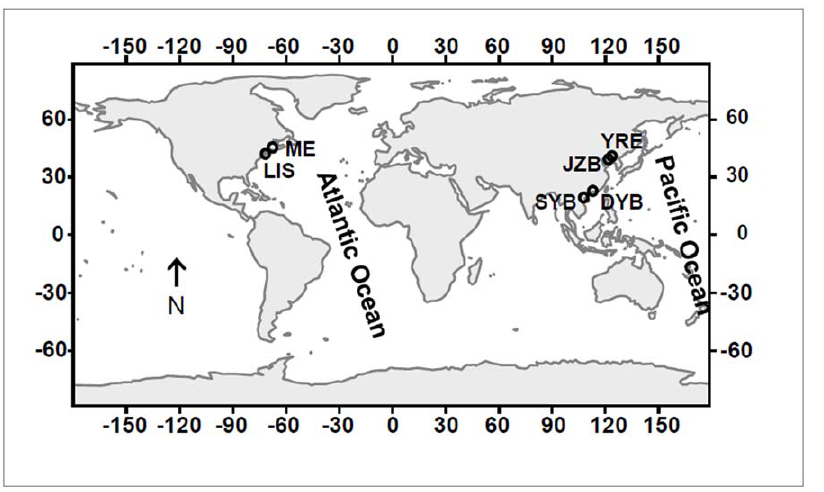
Figure 1. Sampling locations. LIS, Long Island Sound, Connecticut, USA; ME, Penobscot Bay, Maine, USA; SYB, Sanya Bay, China; DYB, Daya Bay, China; JZB, Jiaozhou Bay, China; YRE, Yellow River Estuary, China.